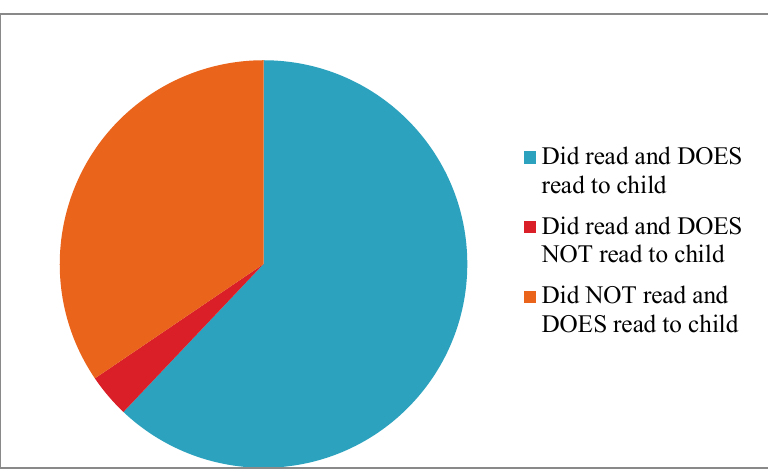
Figure 1 : Link between parents’ reading as a child/ young adult and their shared reading relationship with their own